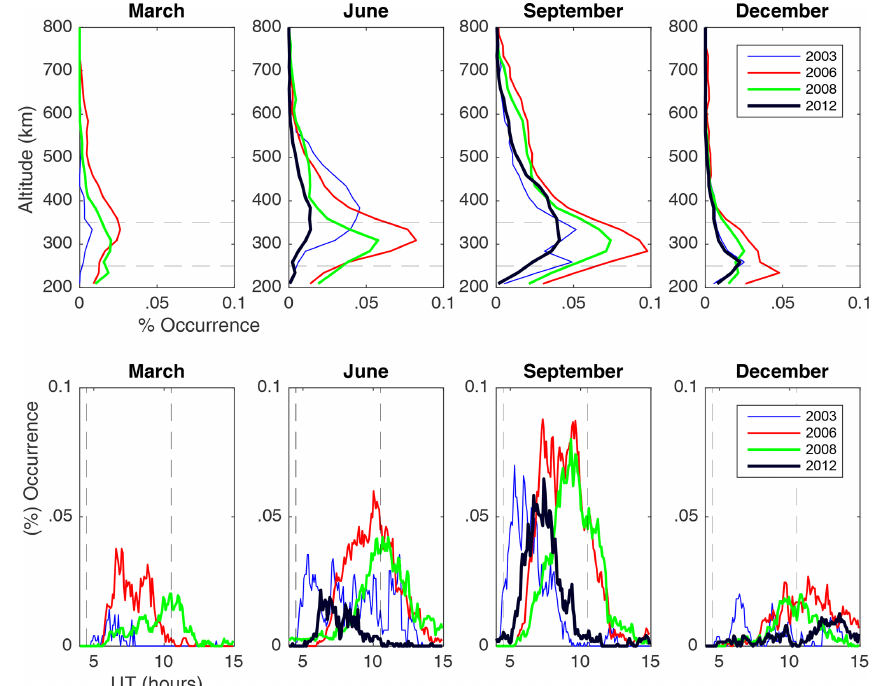
Figure 3. Peak altitude (top panels) and time (bottom panels) variations along the years 2003, 2006, 2008, and 2012, also divided by